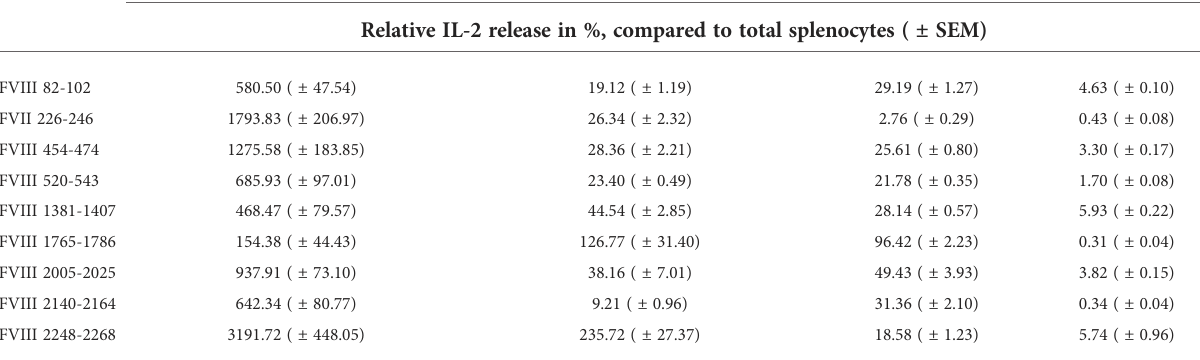
TABLE 1 Capability of different APC populations to present FVIII peptides and subsequently activate FVIII-speci fi c CD4+ T cell hybridoma clones. DCs(CD11c high MHCII+